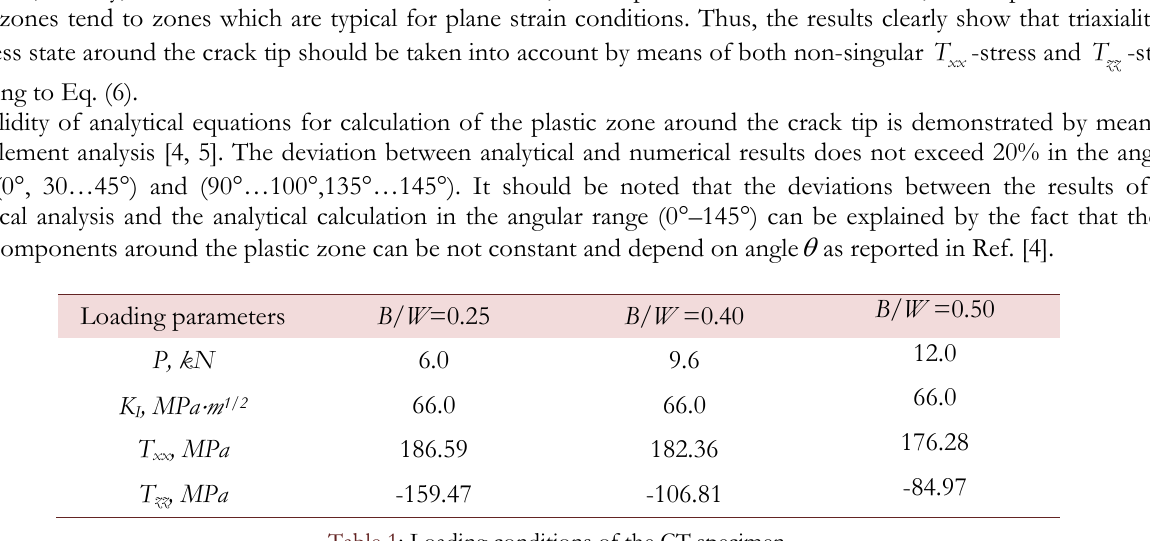
Table 1: Loading conditions of the CT